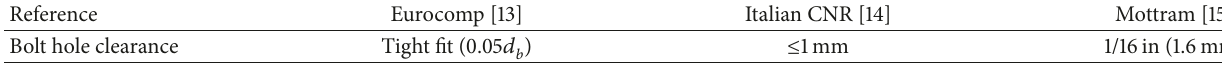
Table 4: Recommended bolt-hole clearance.